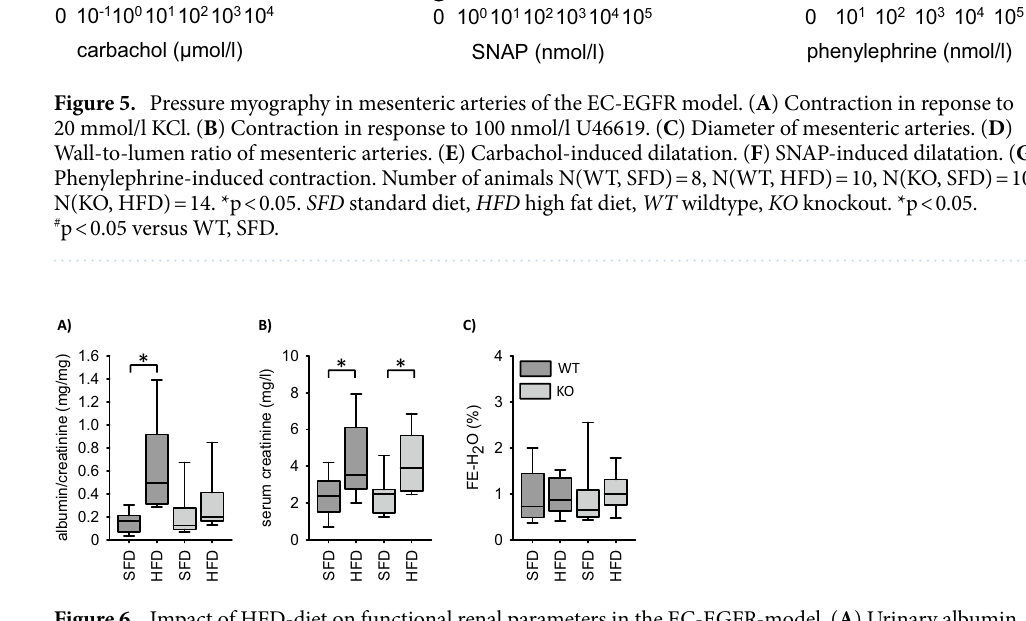
overall HFD-induced vascular remodeling, which is supported by mesenteric artery wall thickening. Altogether, these findings are in contrast to VSMC-EGFR that plays an important role under physiological and pathophysi- ological conditions, as reported previously 2,4,5,15 .